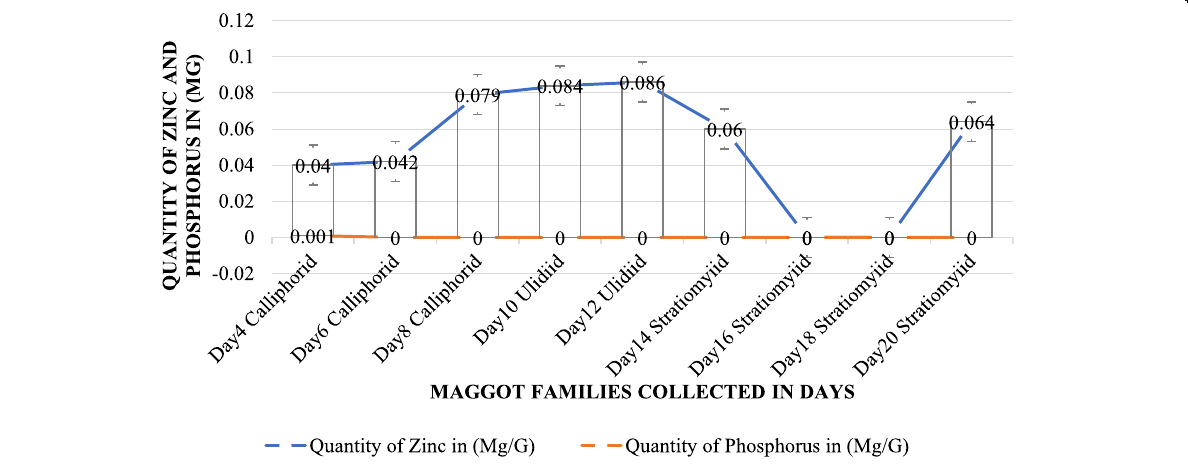
Fig. 5 Quantity of zinc and phosphorus in the maggots during the rainy season at Awka, Nigeria